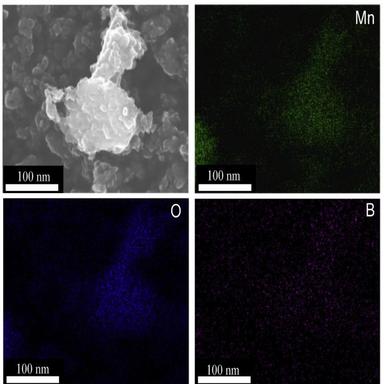
SEM image of LMB/BxOy@C and corresponding energy-dispersive system (EDS) mapping for Mn, O, and B elements.